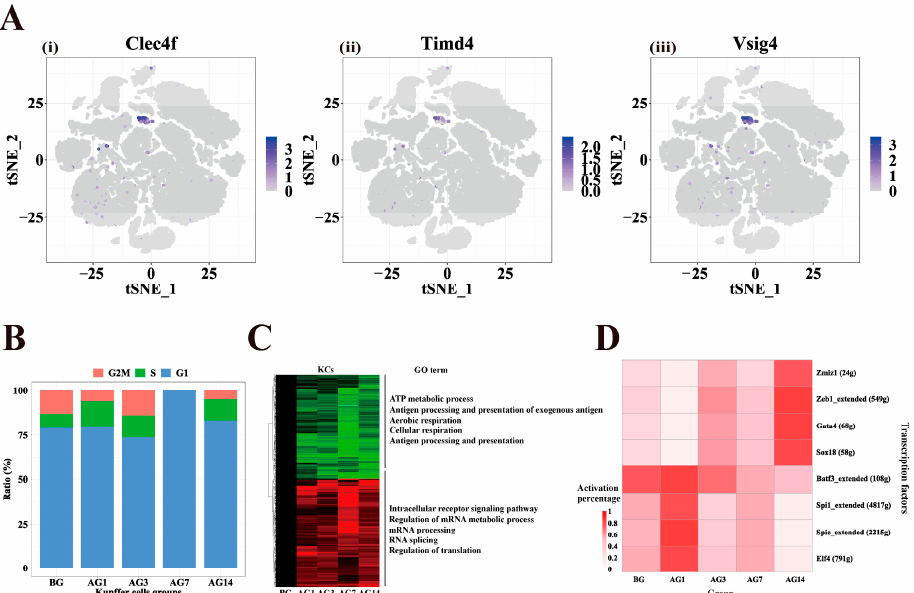
Figure 6. Abnormally expressed genes and transcription factors in Kupffer cells. ( A ) Gene expression of Kupffer cells markers (i) Clec4f , (ii) Timd4 and (iii) Vsig4 . Color bars indicate the expression level in log-scale UMI. ( B ) Distribution of cell cycle phases (G2/M, S, G1) in Kupffer cells of different groups. ( C ) Differentially expressed genes and gene functions between AG1, AG3, AG7and AG14 compared to BG in Kupffer cells. ( D ) Heatmap of the percentage of cells with active regulators in different groups of Kupffer